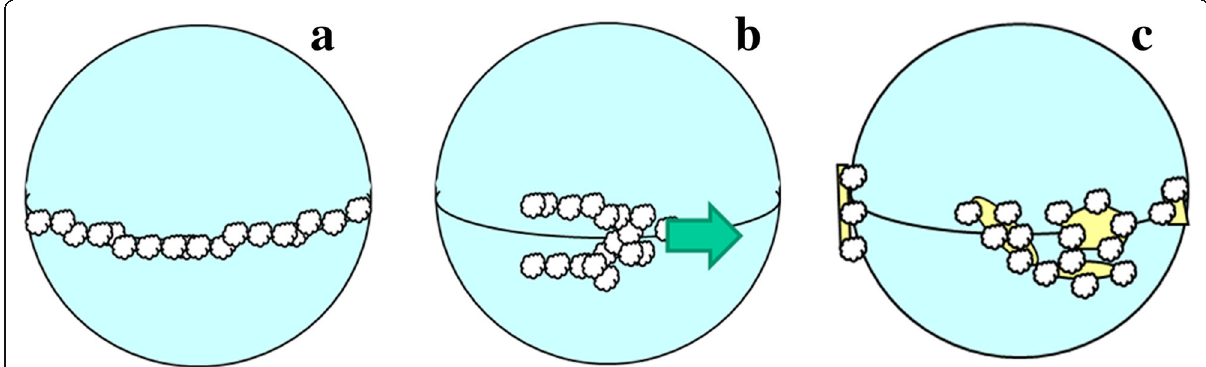
Fig. 2 Schematic diagrams of distributions of tropical precipitation: a simple ITCZ as considered by Hadley in 18th century, b MJOs propagating eastward as simulated in an “ aqua planet ” model (e.g., Hayashi and Sumi 1986), and c concentration along coastlines as described in this